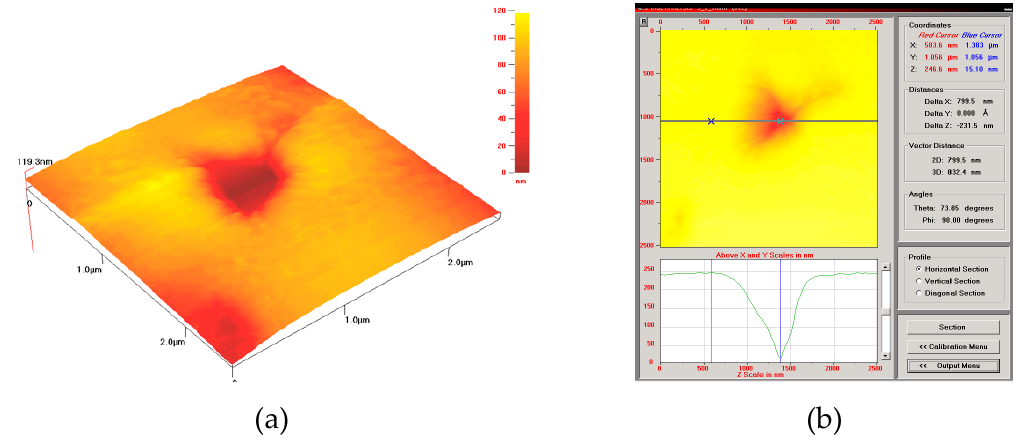
Figure 12. Indents ( a ) and material pile-up ( b ) of SiC-based phase of composite SPSed at 1450 °